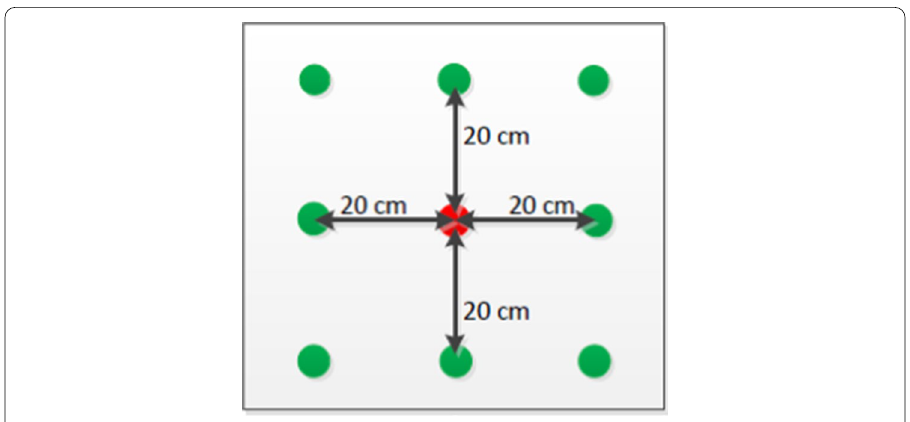
Fig. 5 A 3 × 3 grid of receiver